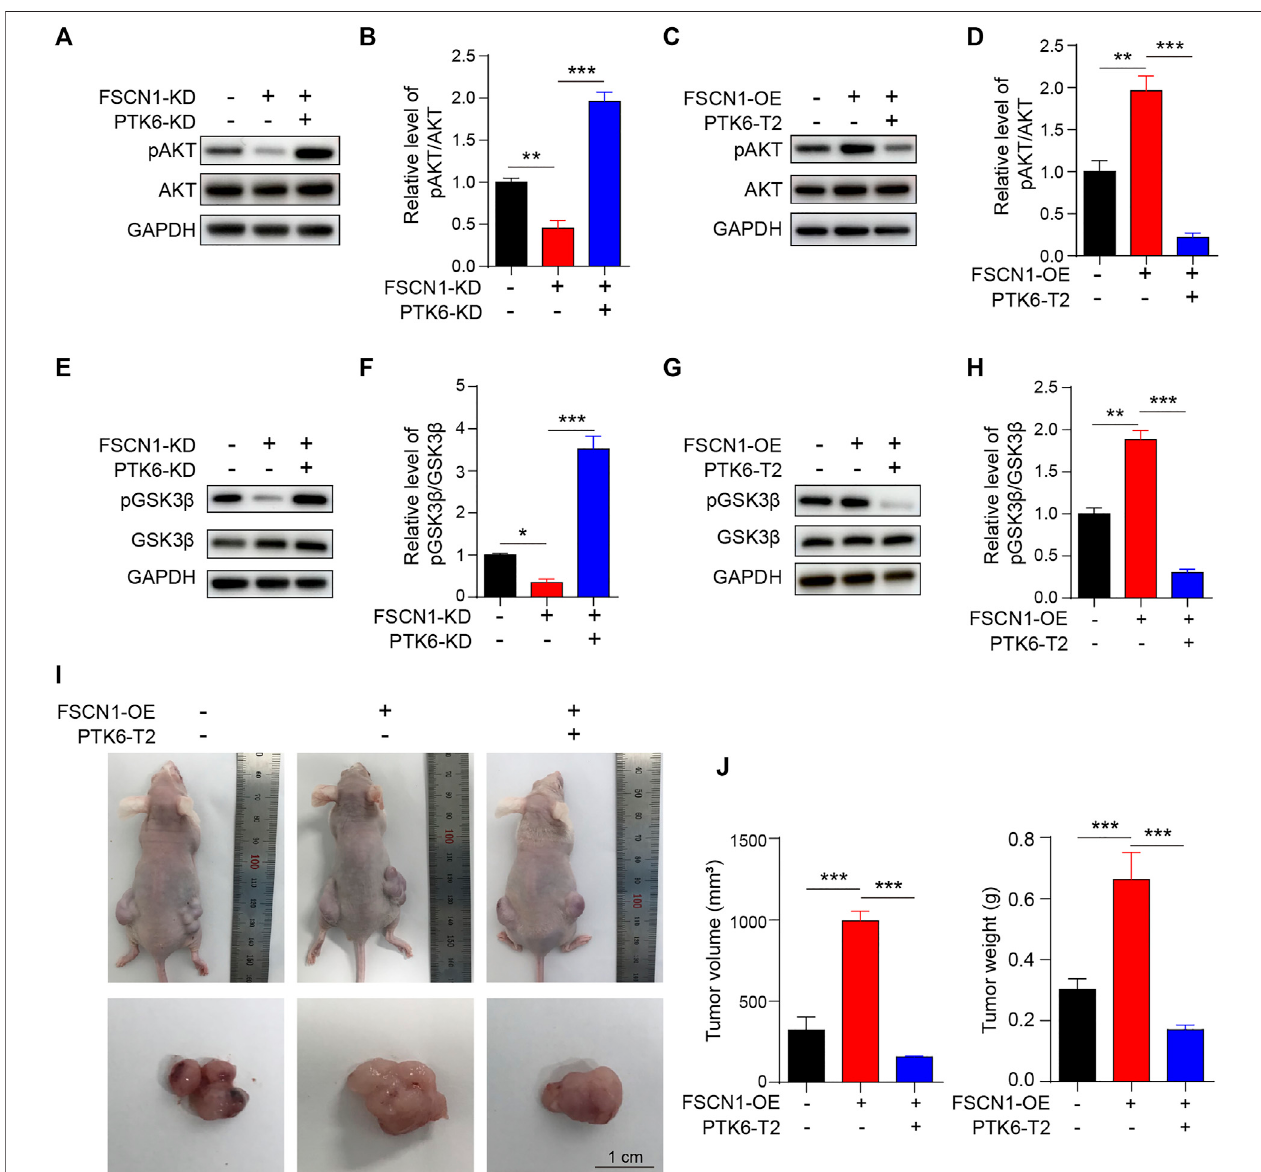
FIGURE 6 | AKT and GSK3 β are the downstream pathways of FSCN1-PTK6 signaling. (A) ECA-109 cells expressing NC, FSCN1-KD, and FSCN1-KD + PTK6-KD as indicatedwereharvested.AKTandpAKTweredetectedbywesternblotting. (B) StatisticalanalysisofA. n =3pergroup,** p < 0.01,*** p < 0.001. (C) ECA-109cellsexpressing NC,FSCN1-OE,andFSCN1-OE+PTK6-T2,asindicated,wereharvested.AKTandpAKTweredetectedbywesternblotting. (D) StatisticalanalysisofC. n =3pergroup,** p < 0.01, *** p < 0.001. (E) ECA-109 cells expressing NC, FSCN1-KD, and FSCN1-KD + PTK6-KD, as indicated, were harvested. GSK3 β and p GSK3 β were detected